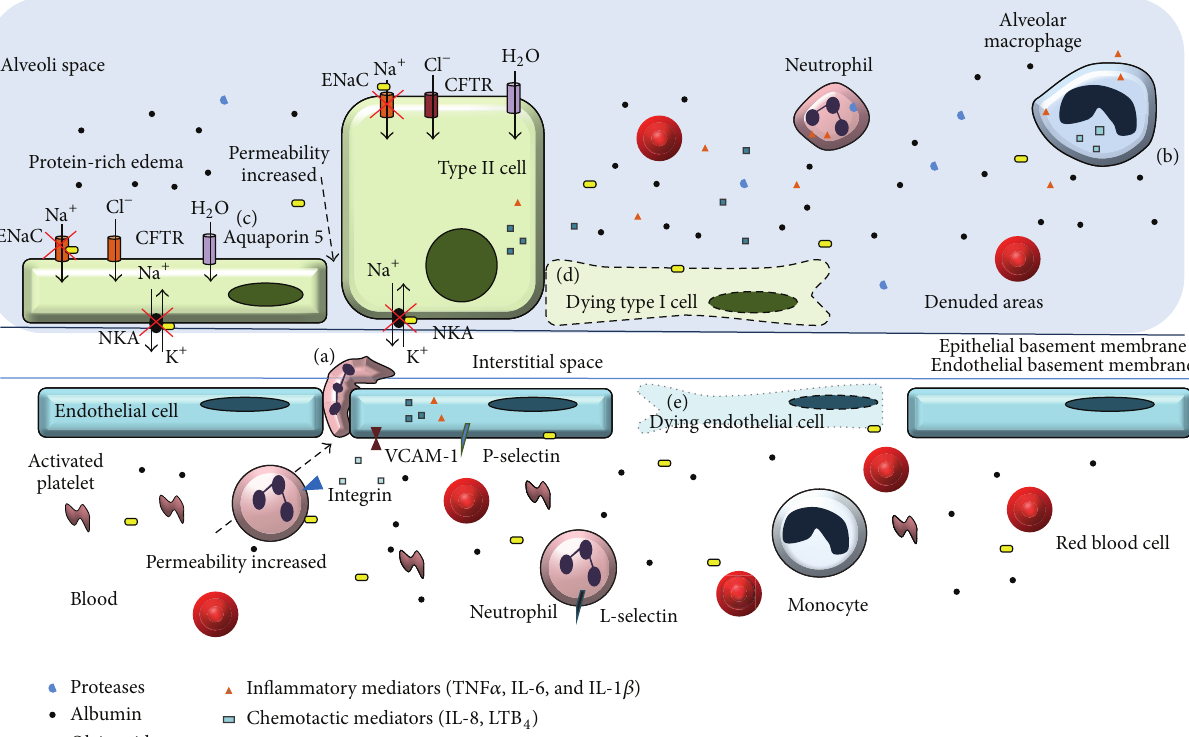
Figure 1: Effects of oleic acid in acute respiratory distress syndrome. Oleic acid induces damage in epithelial and endothelial cells, with increased permeability and protein-rich edema, with denuded areas in alveoli forming a hyaline membrane. Oleic acid induces apoptosis or necrosis in alveolar type I or type II cells (d), depending on the insult origin. Alveolar macrophages (b) act as sentinels triggering the immuneresponseandproducechemotacticandinflammatorymediators. Chemoattractantmediatorsproducedbyalveolarmacrophagesand epithelial and endothelial cells induce increased adhesion molecules such as VCAM-1, selectins, and integrins, favoring the inflammatory cell